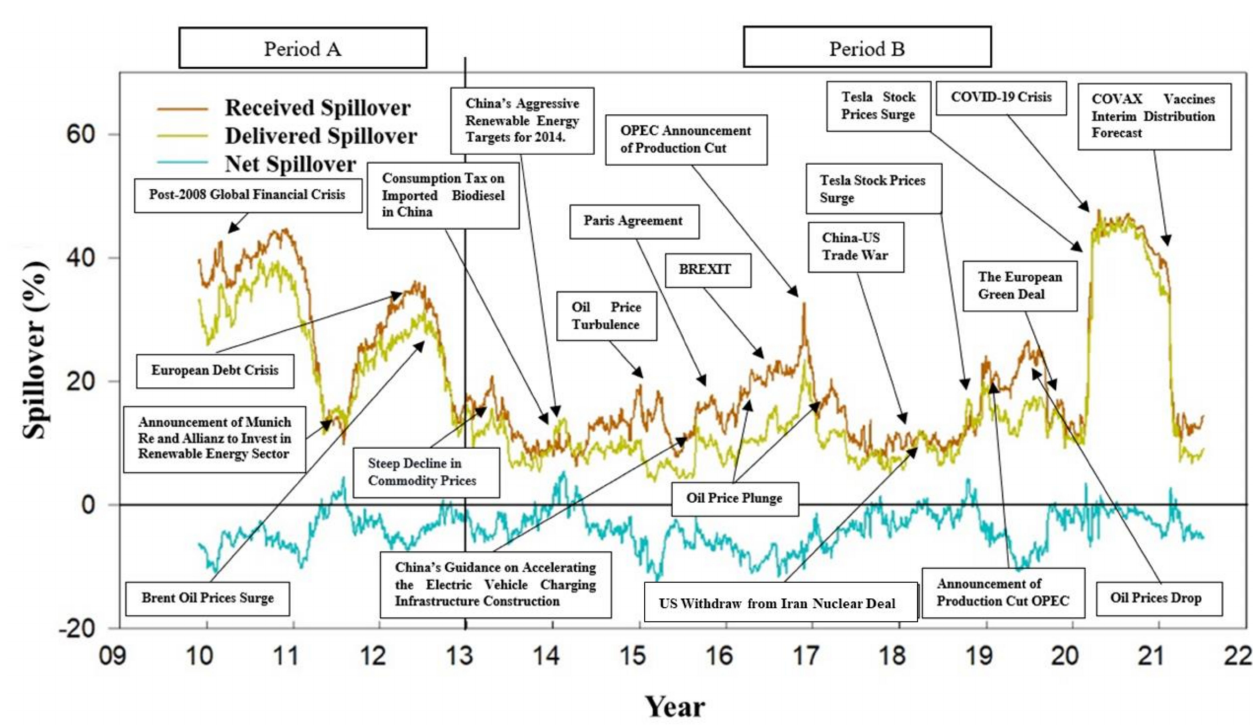
Figure 3. Spillover Plot of Received, Delivered and Net Return Spillovers of the Renewable Energy Market in the “Renewable Energy-Energy” Market System. Note: We plot the time series of the received, delivered and net return spillovers of the RE market in the “Renewable Energy-Energy” market system based on 252-day rolling samples for the period from 1 December 2009 to 8 July 2021. The underlying variance decompositions are based on VAR models with lag orders of 11, as suggested by the AIC. The forecast horizon is 5 days. In the plot, we mark the major market and political events during the studied